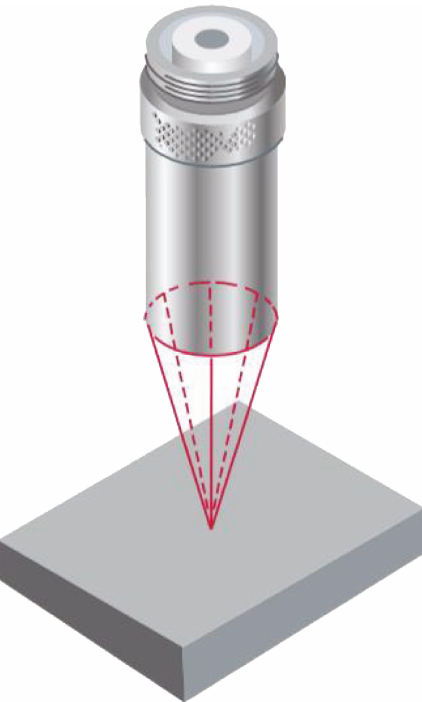
Figure 3: Spherical focus